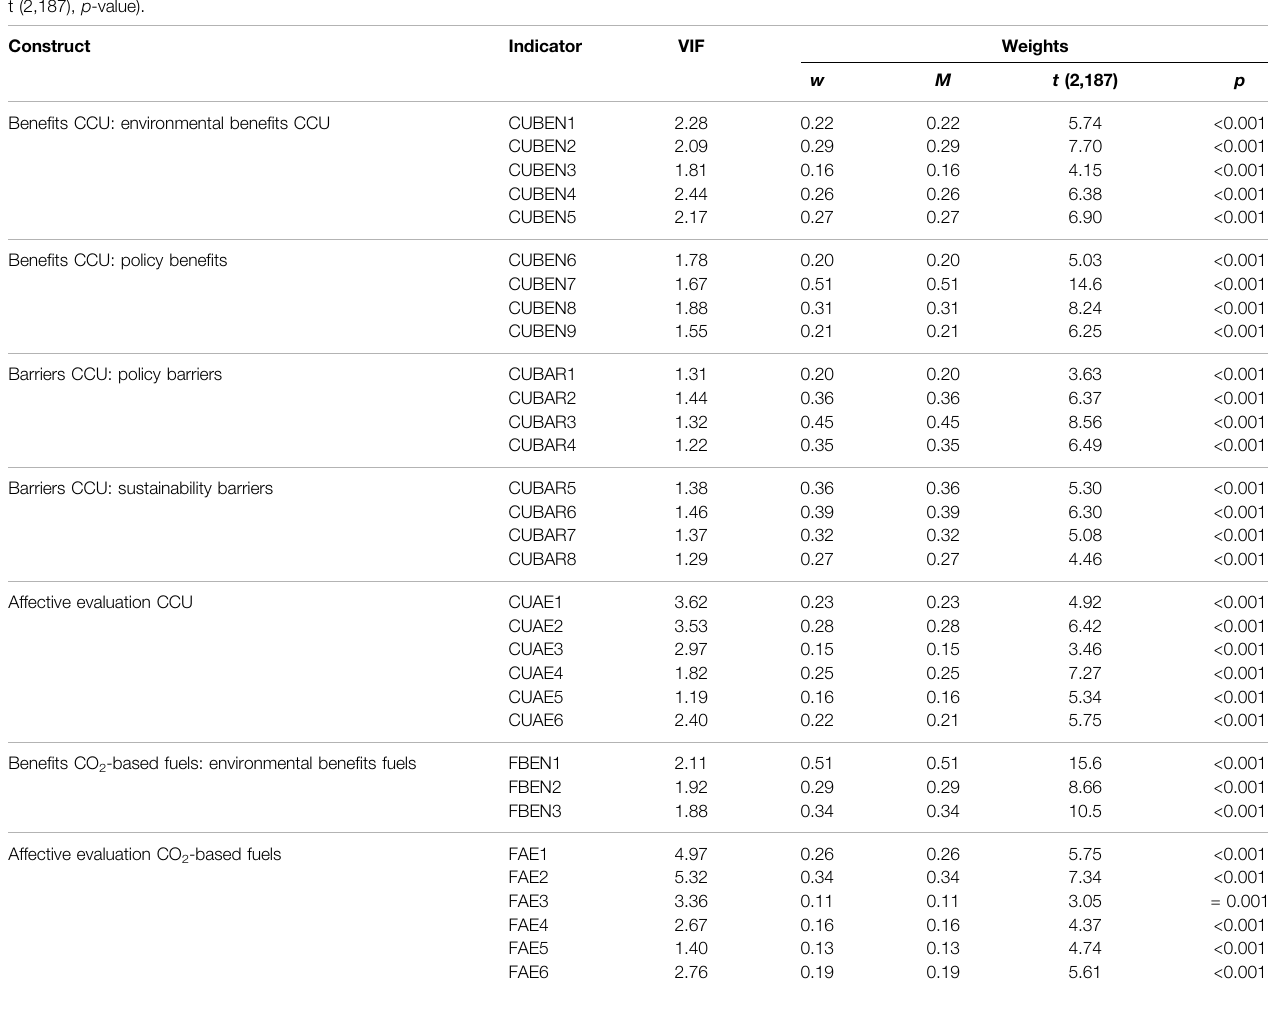
TABLE 4 | Evaluation of the formative constructs and lower-order constructs (LOC): collinearity (VIF) and indicator weight (original estimate w , bootstrap mean M , t-statistic t (2,187), p